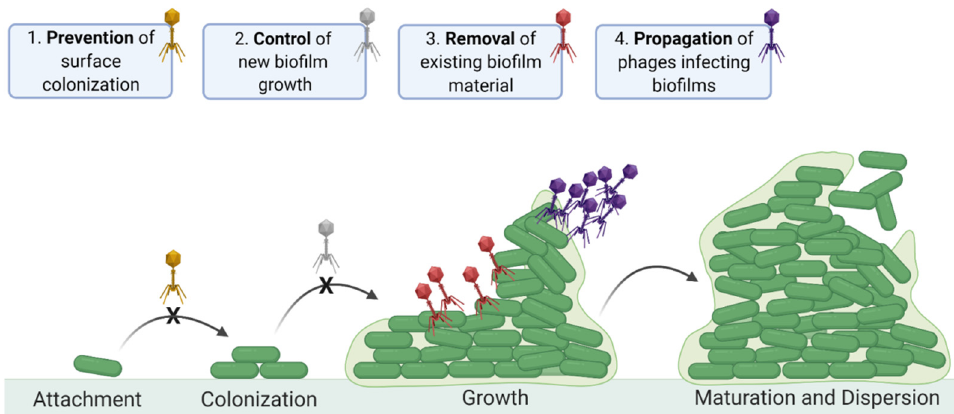
Figure 1. Different aspects of phage-biofilm interactions. Across the bottom: Biofilms begin with bacteria attaching to surfaces and to each other. This is followed by bacterial transition from planktonic to sessile lifestyles ( colonization ) and then to increases in biofilm bulk, i.e., as a consequence of a combination of biofilm-bacteria replication and extracellular matrix production ( growth ). Net growth ceases in association with biofilm maturation . Biofilms also can display various forms of cell dispersion , allowing for colonization of new surfaces. Across the top: (1) Phage prevention of bacterial surface colonization (mustard-colored virions), (2) phage-associated control of growth in biofilm bulk (gray-colored virions), and (3) phage-mediated removal of existing biofilm material (red-colored virions). In addition, (4) phages can produce new virions ( propagation , purple-colored virions). This figure has been adapted from “Polymicrobial biofilm” by BioRender.com (2020) and retrieved from https://app.biorender.com/biorender-templates.